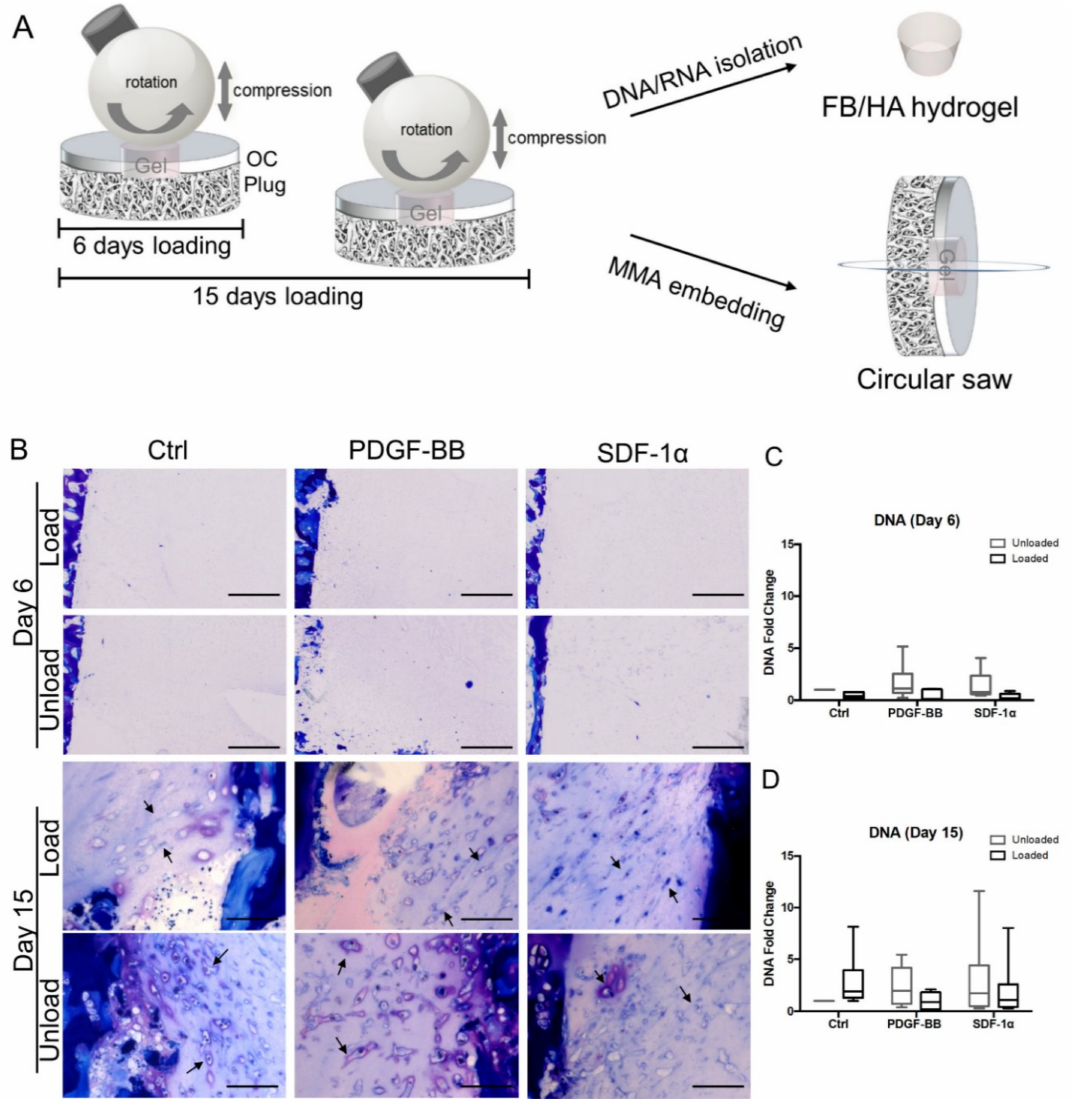
Figure 1. E ff ect of mechanical stimuli on cells migrating into an ex vivo osteochondral defect filled with FB / HA hydrogels. ( A ) Schematic representation of the experimental design used for cell migration experiments; OC Plug: Osteochondral explant; Gel: FB / HA hydrogel. ( B ) Representative images of osteochondral constructs stained with Toluidine blue (purple = glycosaminoglycan) showing cells infiltrating the defect after 6 and 15 days in presence or absence of mechanical stimuli; 20X magnification; scale bar indicates 100 µ m. ( C , D ) Relative DNA content of unloaded and loaded cell infiltrating FB / HA hydrogels casted in the osteochondral defect models cultured for 6 and 15 days. Data were normalized to the DNA content of unloaded samples without chemokine addition. Results of 6 donors (day 6) and 10 donors (day 15) (one osteochondral explant per donor) are